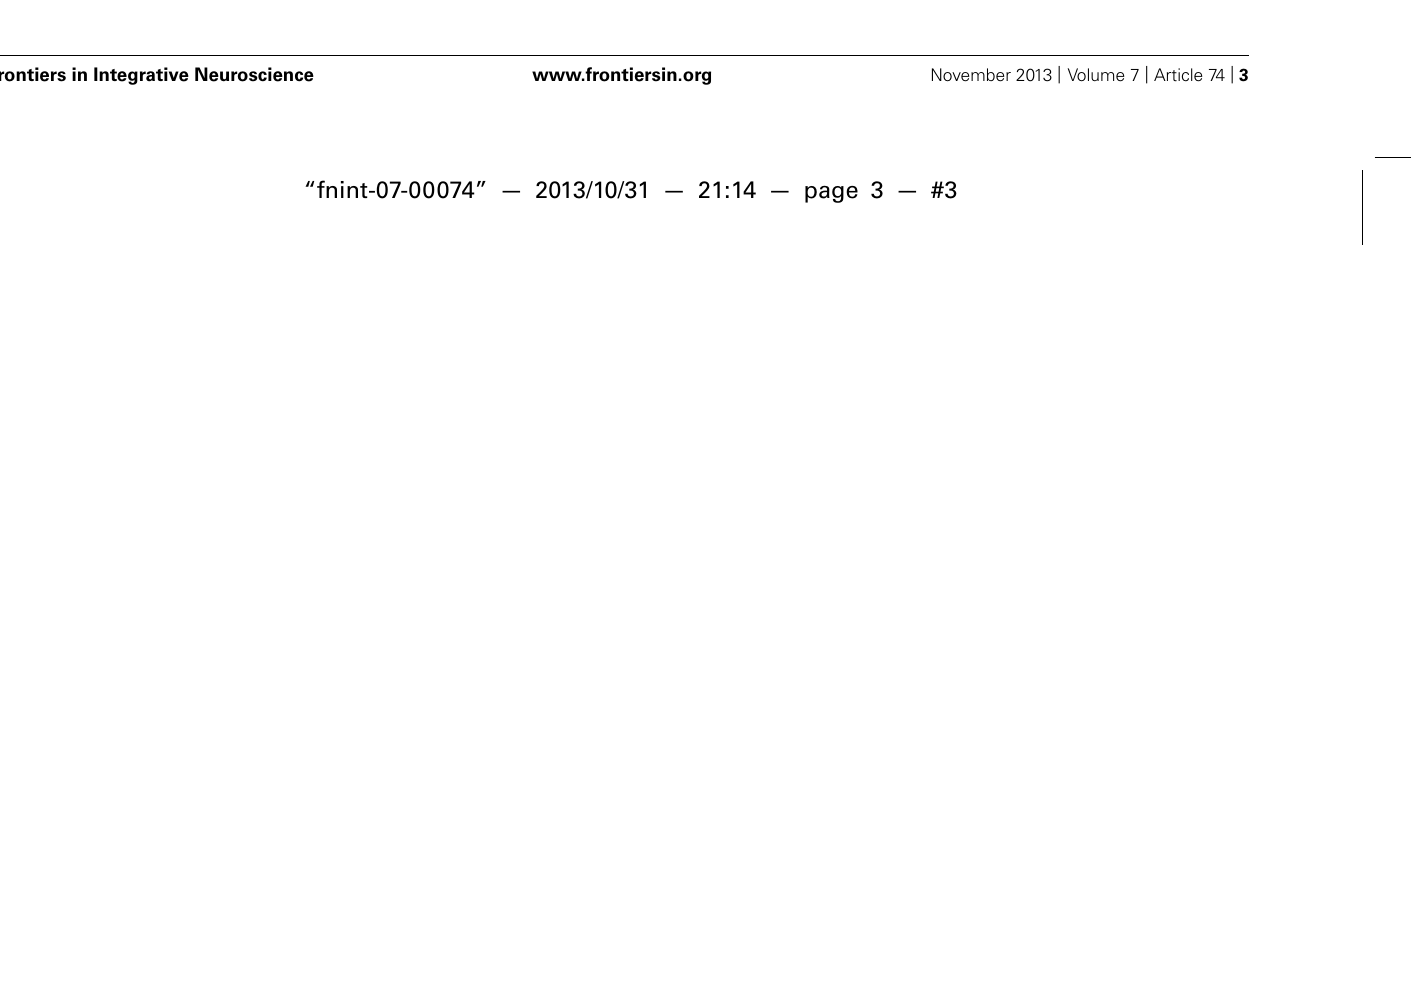
Possible combinations of movements during the free action generation task. appropriate key, within 800 ms of the visual and auditory